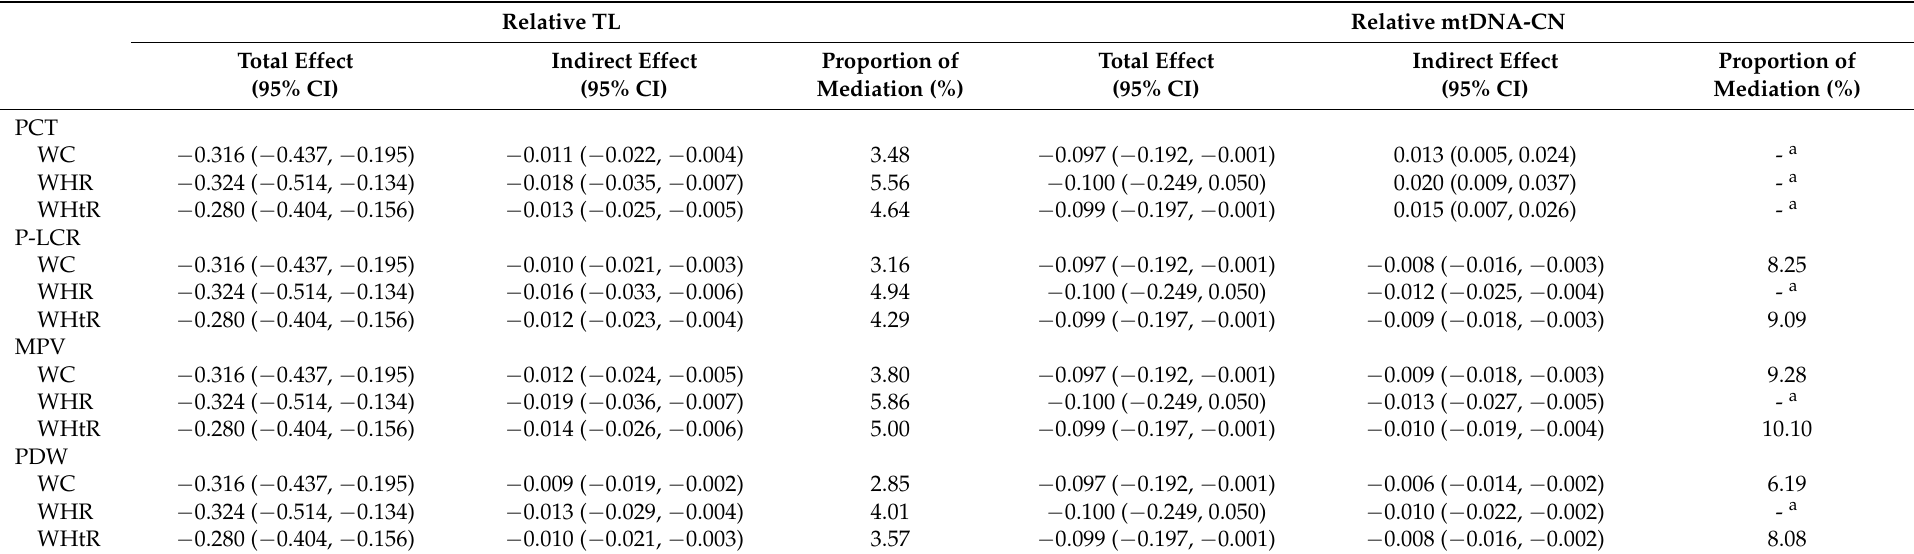
Table 3. Total and indirect effect of obesity indices with aging biomarkers mediated by platelet